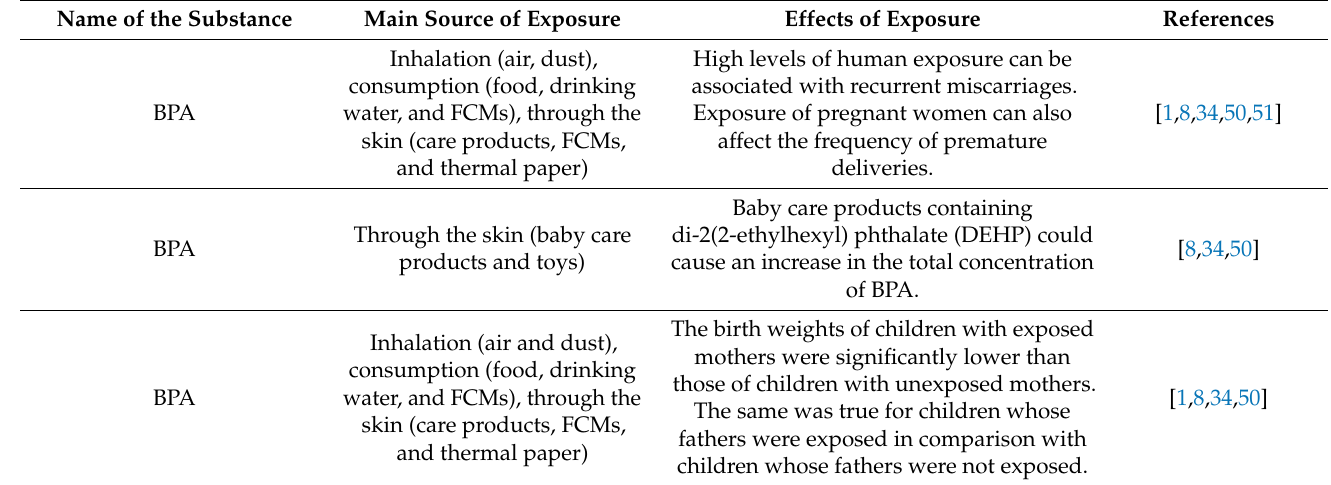
Table 5. Impacts of selected bisphenols on human